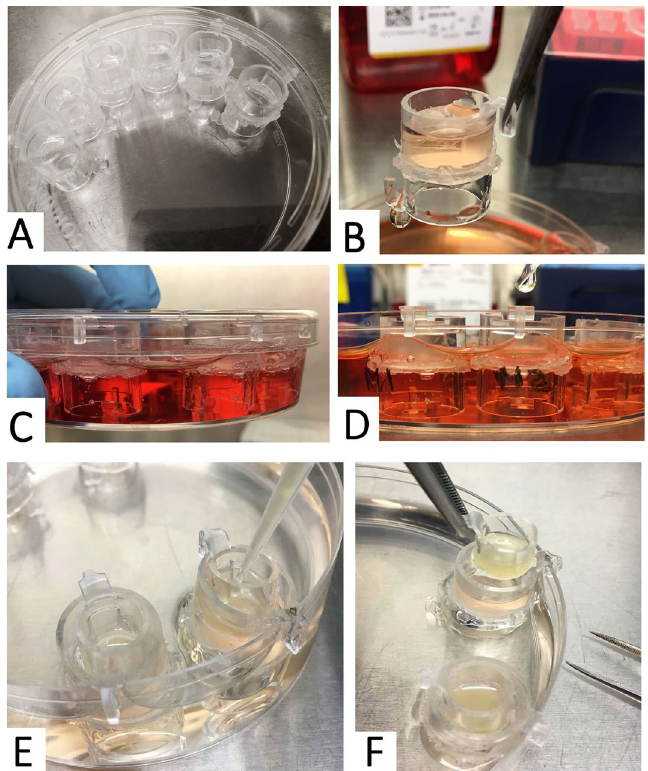
Figure 3. 3D Flipwell construction and culturing. ( A ) Constructed 3D Flipwells after two inserts were glued together with a silicone sealant and membranes are coated with PureCol. Flipwells were spaced along the rim of a deep-well petri-dish. ( B ) Flipwells were seeded with cells on one side. ( C ) Top inserts (topside of the membrane) were seeded with Caco2/HT-29 cells and maintained until cells settled. ( D ) Flipwells were flipped and the bottom inserts (underside of the membrane) were seeded with non-adherent THP-1 monocytes. Cells were treated with PMA for differentiation to adherent macrophages. ( E ) After cell attachment, Flipwells were flipped to have colon epithelial cells faced upwards so that they produced overhanging mucus in 2–3 weeks. A smaller insert containing bacteria was added onto the insert with colon epithelial cells and left for 3 h. ( F ) Bacterial insert was removed and co-culture was left for 3 days with daily medium